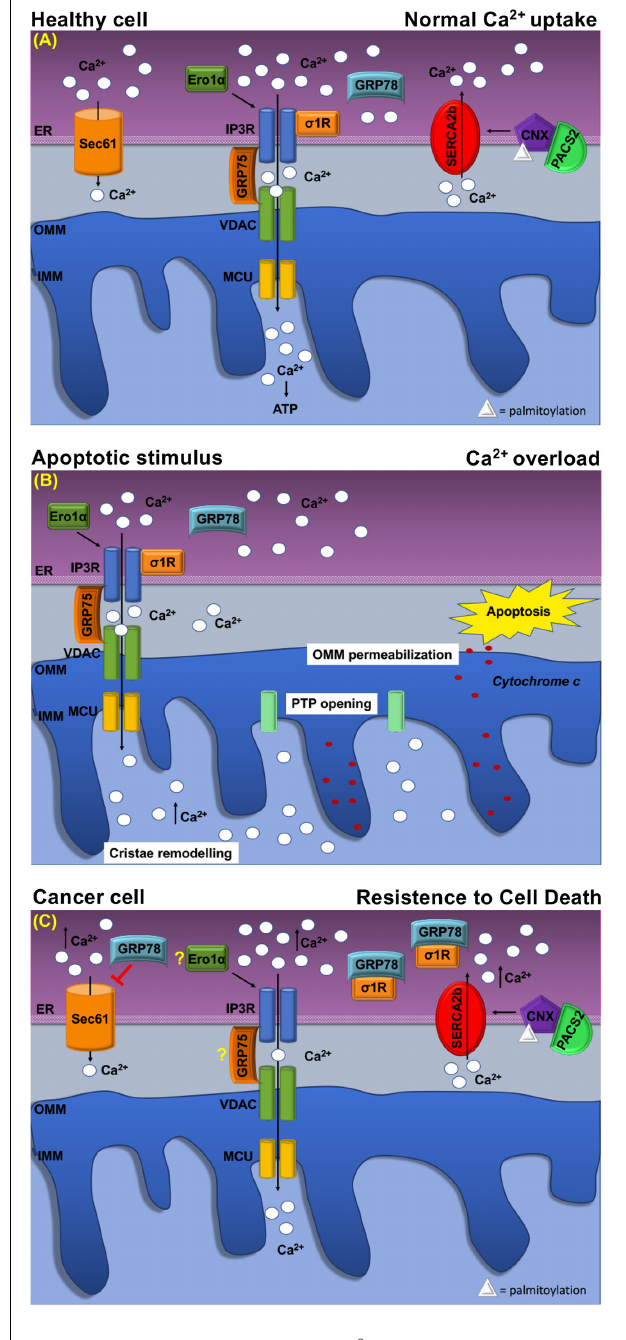
FIGURE 3 | Schematic representation of Ca 2 + handling at MERCs in healthy cell and cancer cell. (A) Healthy cell: The ER Ca 2 + load is determined by ER Ca 2 + uptake systems sarco-ER Ca2 + transport ATPases (SERCAs) and Ca 2 + -binding protein calnexin (CLNX), which is targeted to MERCs following a phosphofurin-acidic cluster sorting protein 2 (PACS2)-dependent palmitoylation to maintain high Ca 2 + levels with the ER. Ca 2 + is released from the ER through the activation of inositol 1,4,5-tris phosphate receptors (IP3Rs) Ca 2 + channels that are physically connected to voltage-dependent anion channel (VDAC) located at the outer mitochondrial membrane (OMM) via glucose-regulated protein 75-kDa (GRP75). The Ca 2 + ions transferred through the IP3Rs–GRP75–VDAC complex are imported into the